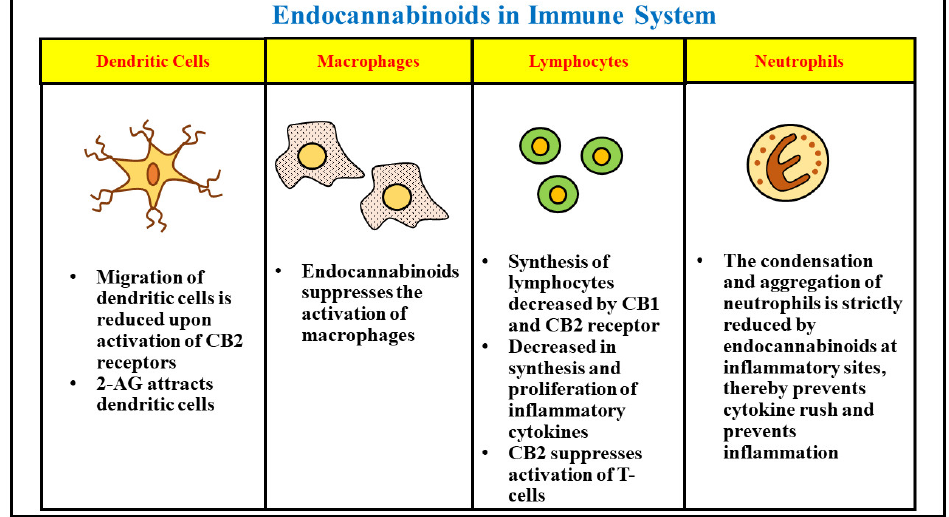
Figure 4. The figure concisely presents the role of endocannabinoids in growth, proliferation, activ- ity and functions of different types of inflammatory cells in the immune